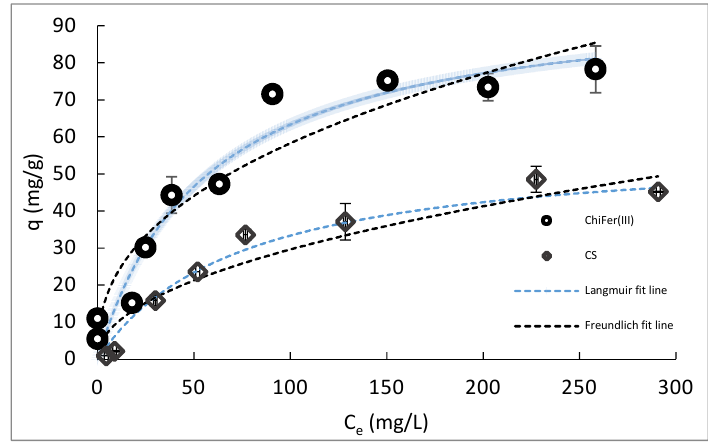
Figure 4. Adsorption isotherm. (T = 20 °C; pH: 6, dose: 1 g/L, contact time: 24 h, agitation rate: 150 rpm).